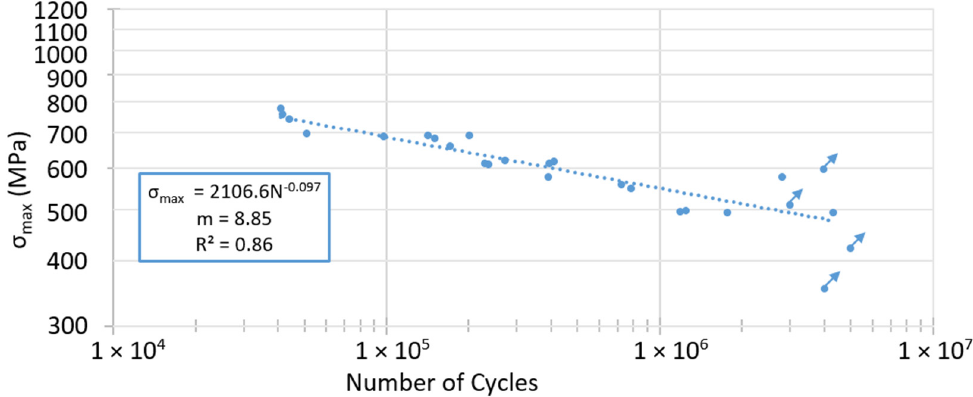
Figure 15. S-N curve, grouped standard and miniature specimens, R=0.1.